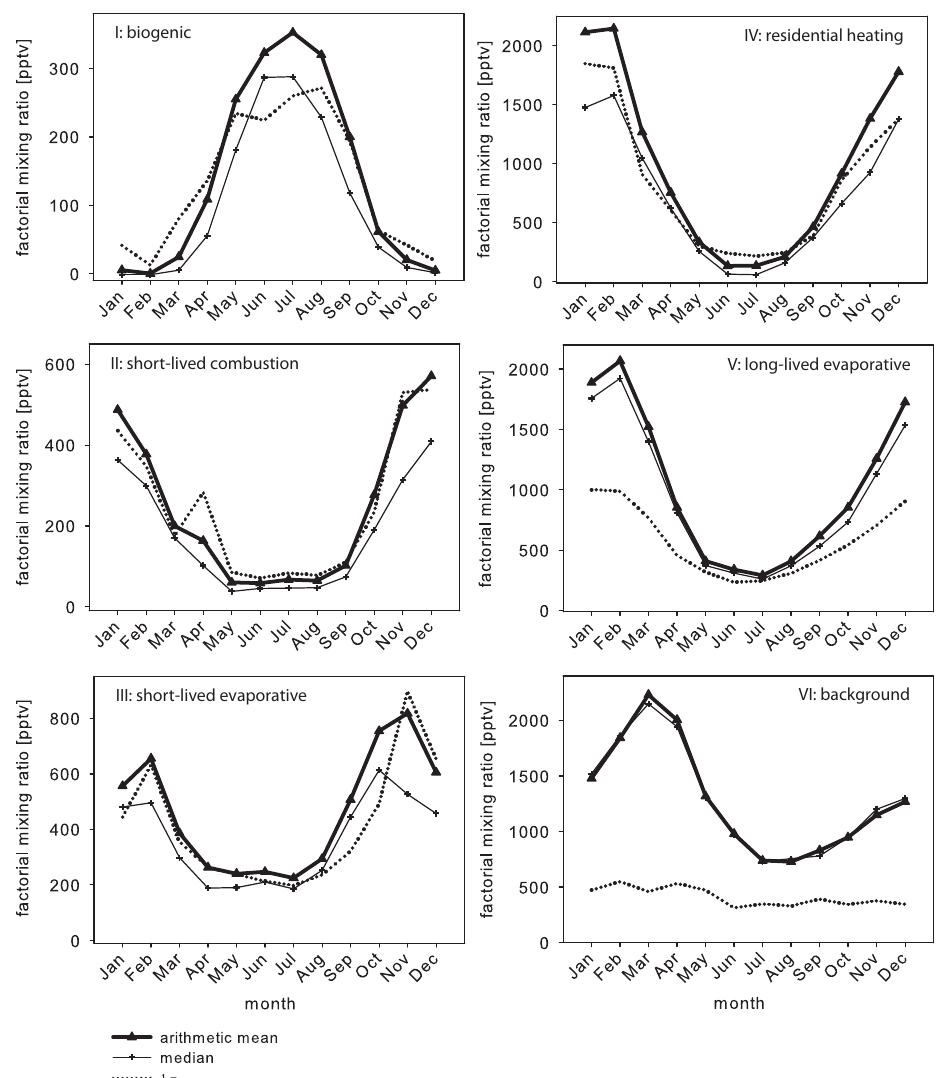
Figure 4. Annual pattern of the mean, median, and standard deviation of the factorial mixing ratio (pptv) of the respective source